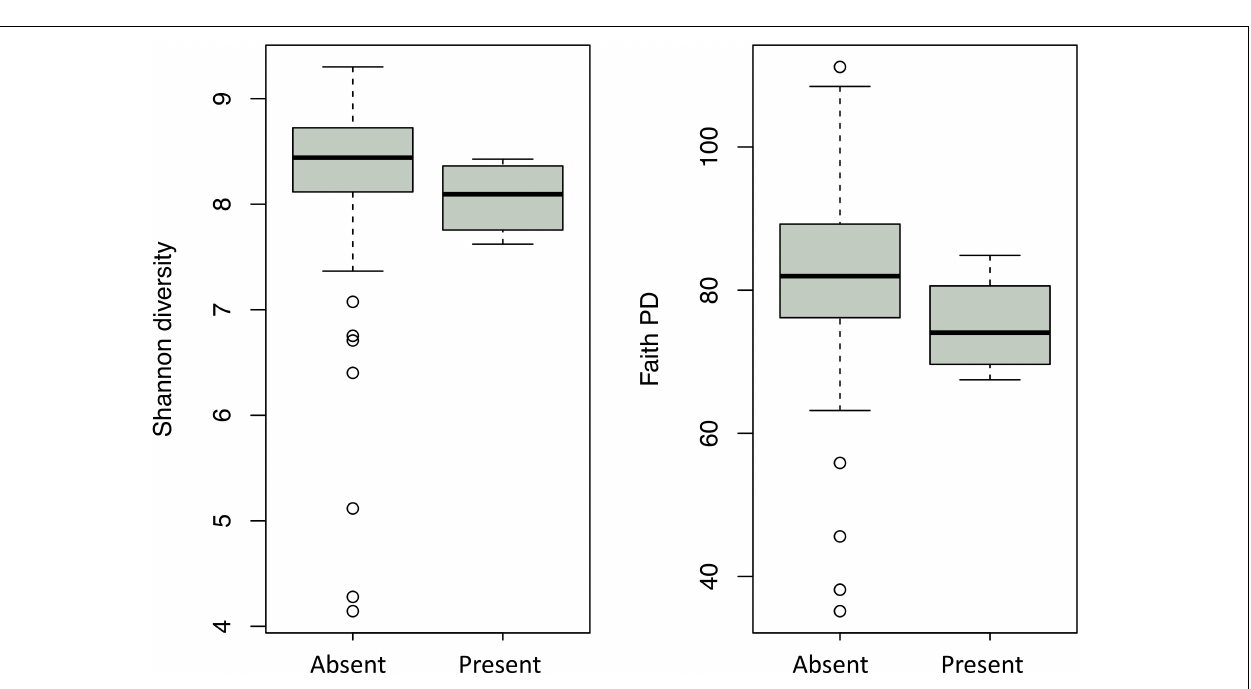
FIGURE 5 | Microbial diversity in soils with and without Yersinia . Left: ecological diversity measured by the Shannon index. Right: phylogenetic diversity measured by the Faith phylogenetic diversity